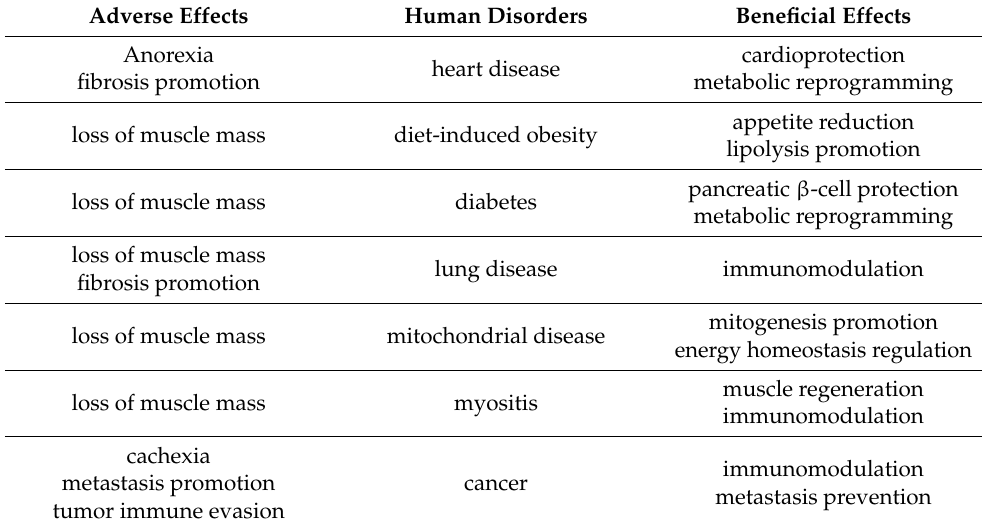
Table 1. Summary of the proposed ambiguous effects displayed by growth differentiation factor-15 in human